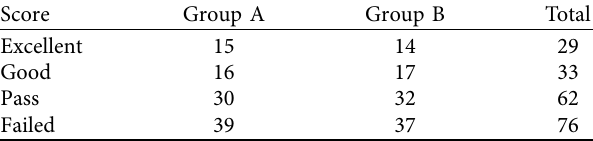
Table 1: Basic grades of 200 college